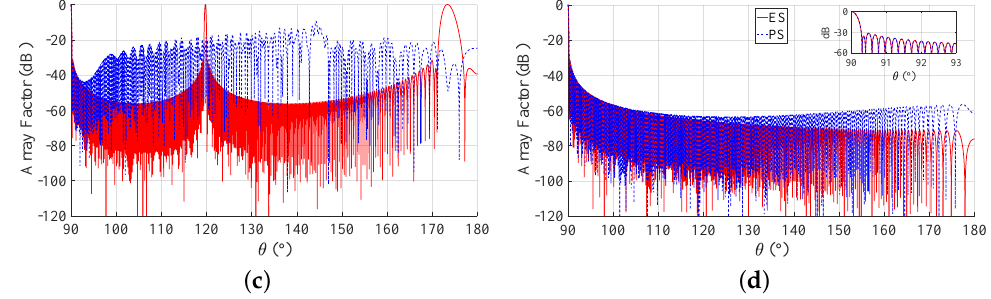
Figure 7. Array factors of the Gaussian approach obtained with b = 3. Blue dashed lines refer to PS, and red solid lines refer to ES: ( a ) desired BW = 1 ◦ , L / λ = 60, N = 30, ( b ) desired BW = 1 ◦ , L / λ = 60, N = 300, ( c ) desired BW = 0.1 ◦ , L / λ = 300, N = 150, and ( d ) desired BW = 0.1 ◦ , L / λ = 300, N = 1500. The inset in the last subfigure reports a zoom of the main beam and of the first